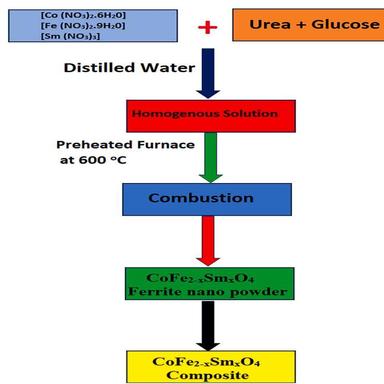
Flowchart of preparation of ferrite powder CoFe2-xSmxO4 (x = 0.0, 0.050, 0.075, 0.1).